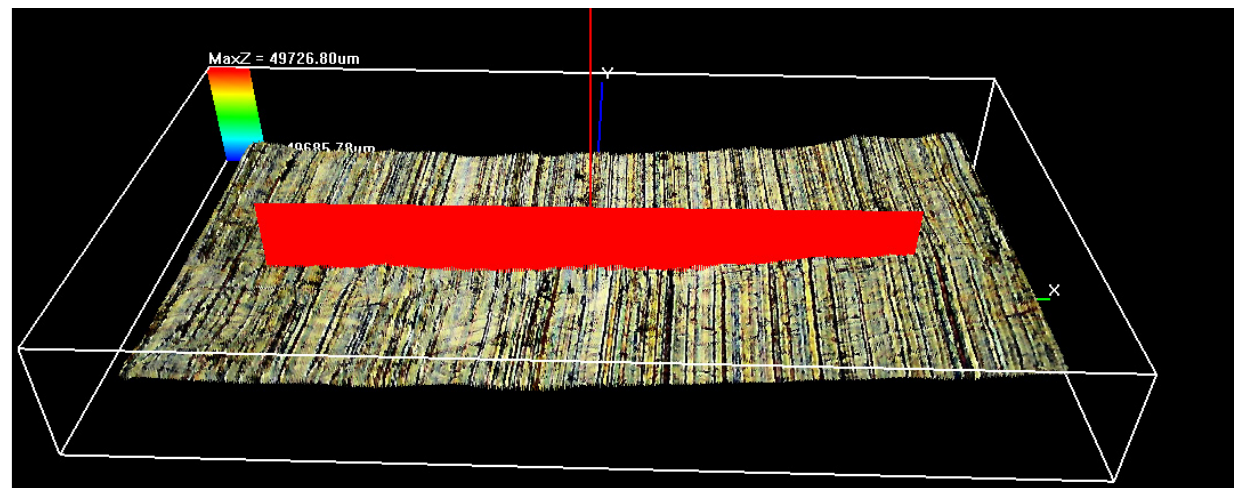
Figure 19. Workpiece surface topography machined by DACT.